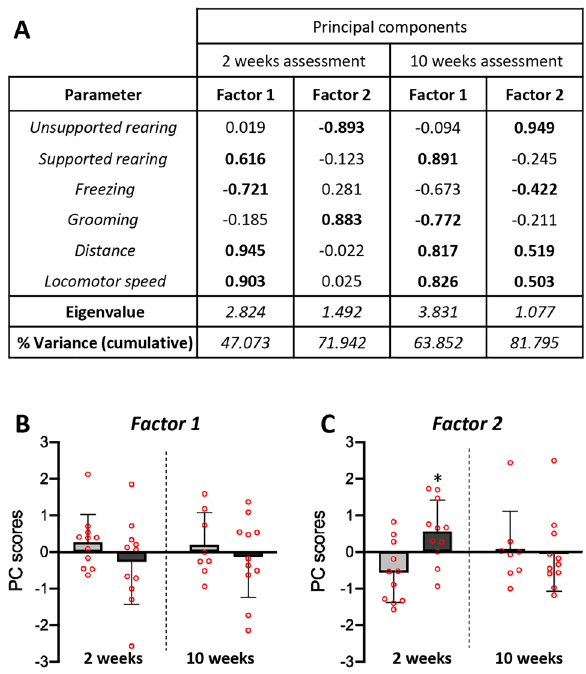
Figure 4. Principal component analysis (PCA) carried out with behavioral parameters obtained in the open field test. The PCA was carried out with the data obtained in the behavioral assessment performed at 2 weeks (2w) post-ICV injection as well as 10 weeks (10w) post-ICV injection. For the data obtained in the 2 weeks assessment KMO = 0.506, χ 2 = 83.839, and P < 0.001. For the data from 10 weeks assessment KMO = 0.758, χ 2 = 128.546, and P < 0.001. The PC scores for each of the parameters used in the PCA and the factors resulting (Eigenvalue > 1) from the analysis are presented ( A ). Interpretable factor loadings (> 0.50) are highlighted in bold, being positively or inversely correlated with each factor. The parameters’ scores in each factor suggest to relate Factor 1 to locomotor capacity, and Factor 2 to the animal’s emotional state. Representation with histograms of the PC scores for Factor 1 ( B ) and Factor 2 ( C ) obtained in the PCA at both evaluation times. Animals ICV-injected with NA showed the highest score for Factor 2 after 2 weeks of the ICV. In order to reveal any significant difference between treatments, a Student’s t -test was conducted. The bars represent the mean value ± SEM. Significant differences are shown with asterisk: * p <